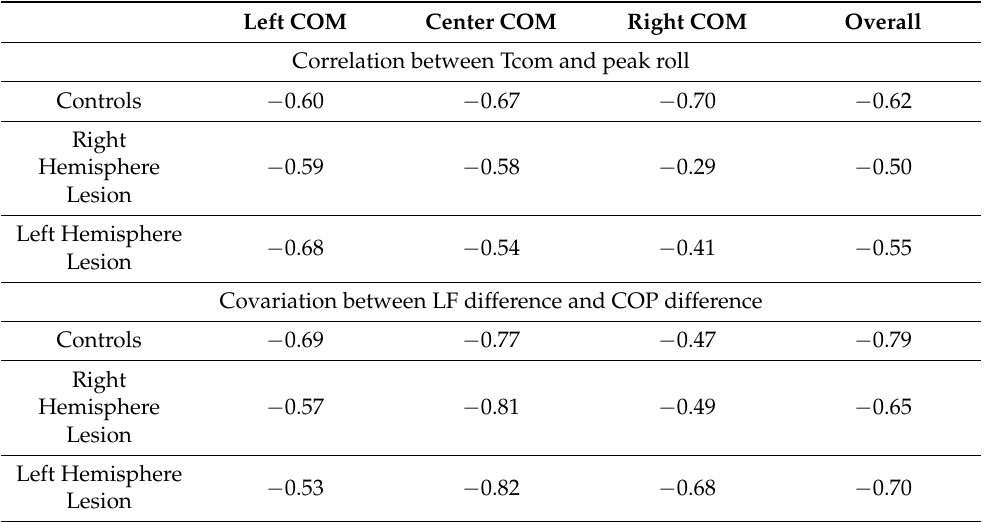
Table 3. Mean correlations between Tcom and peak object roll for the left, center and right center of mass locations and the overall correlation for all of the center of mass locations combined for each group. Covariation between load force difference (LF difference) and center of pressure (COP) difference for the left, center and right center of mass locations and the overall correlation for all of the center of mass locations combined for each group. Spearman’s correlation was used to obtain the correlation between Tcom and peak roll, while Pearson’s r correlation coefficient was used for LF difference and COP difference. Fisher’s z transformation was used to obtain the average correlation coefficient r for each center of mass location across all participants in each group. Left COM Center COM Right COM